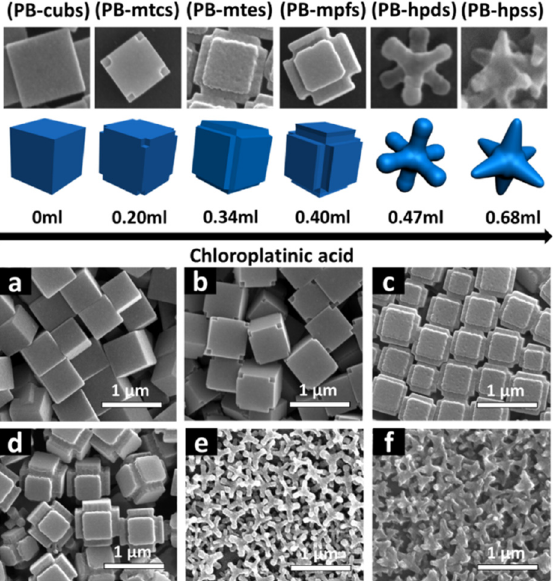
Figure 7. SEM images of PB crystals of different morphology obtained increasing the concentra- tion of chloroplatinic acid. a) PB-cubs: microcubes; b) PB-mcts: PB cubs with truncated corners; c) of chloroplatinic acid. ( a ) PB-cubs: microcubes; ( b ) PB-mcts: PB cubs with truncated corners; ( c ) PB-mtes: PB cubs with truncated edges; d) PB-mpfs: PB cubs with protrusive faces; e) PB-hpds: PB-mtes: PB cubs with truncated edges; ( d ) PB-mpfs: PB cubs with protrusive faces; ( e ) PB-hpds: hexapods; and f) PB-hpss: hexapod stars. Reproduced with permission from [57]. hexapods; and ( f ) PB-hpss: hexapod stars. Reproduced with permission from By modulating ROS production, PB/PBA can be exploited for disease therapeutics.